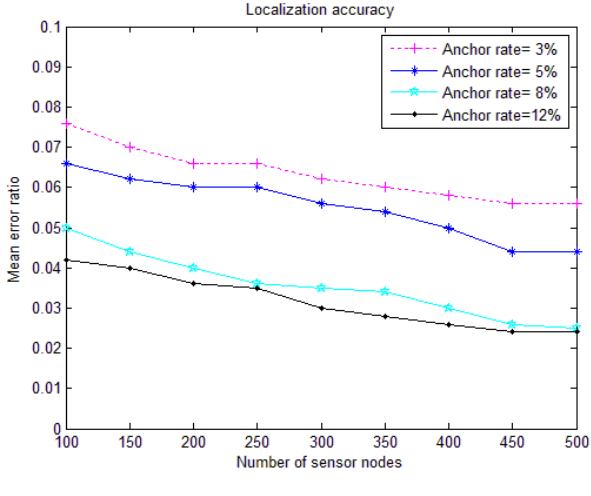
Figure 8. Mean error ratio for RLS.